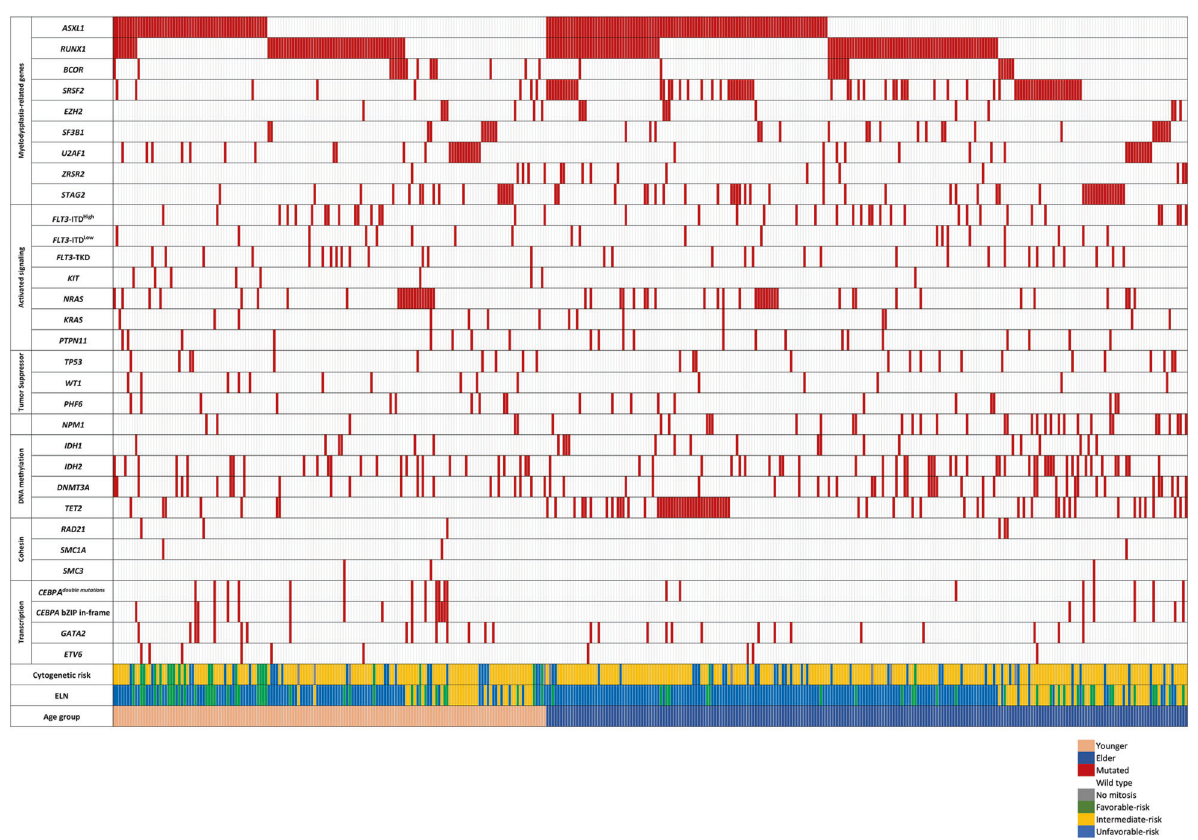
Fig. 1 Comutation plot showing the complex interactions between MDS-R mutations and other mutations. Each column represents a patient. The left side of the plot represents the younger patient group and the right side represents the elder patient group (the last